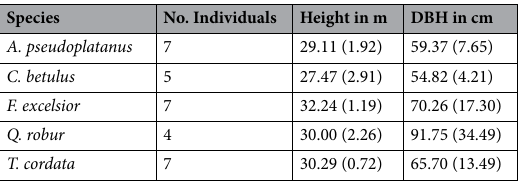
Table 3. Morphological characteristics per species, standard deviation is given in